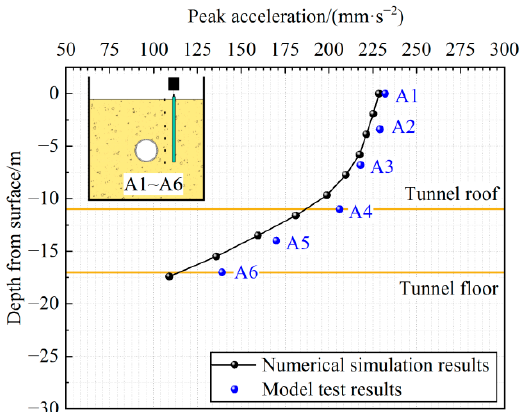
Figure 6. Peak acceleration curves at different depths from the surface (A1~A6).